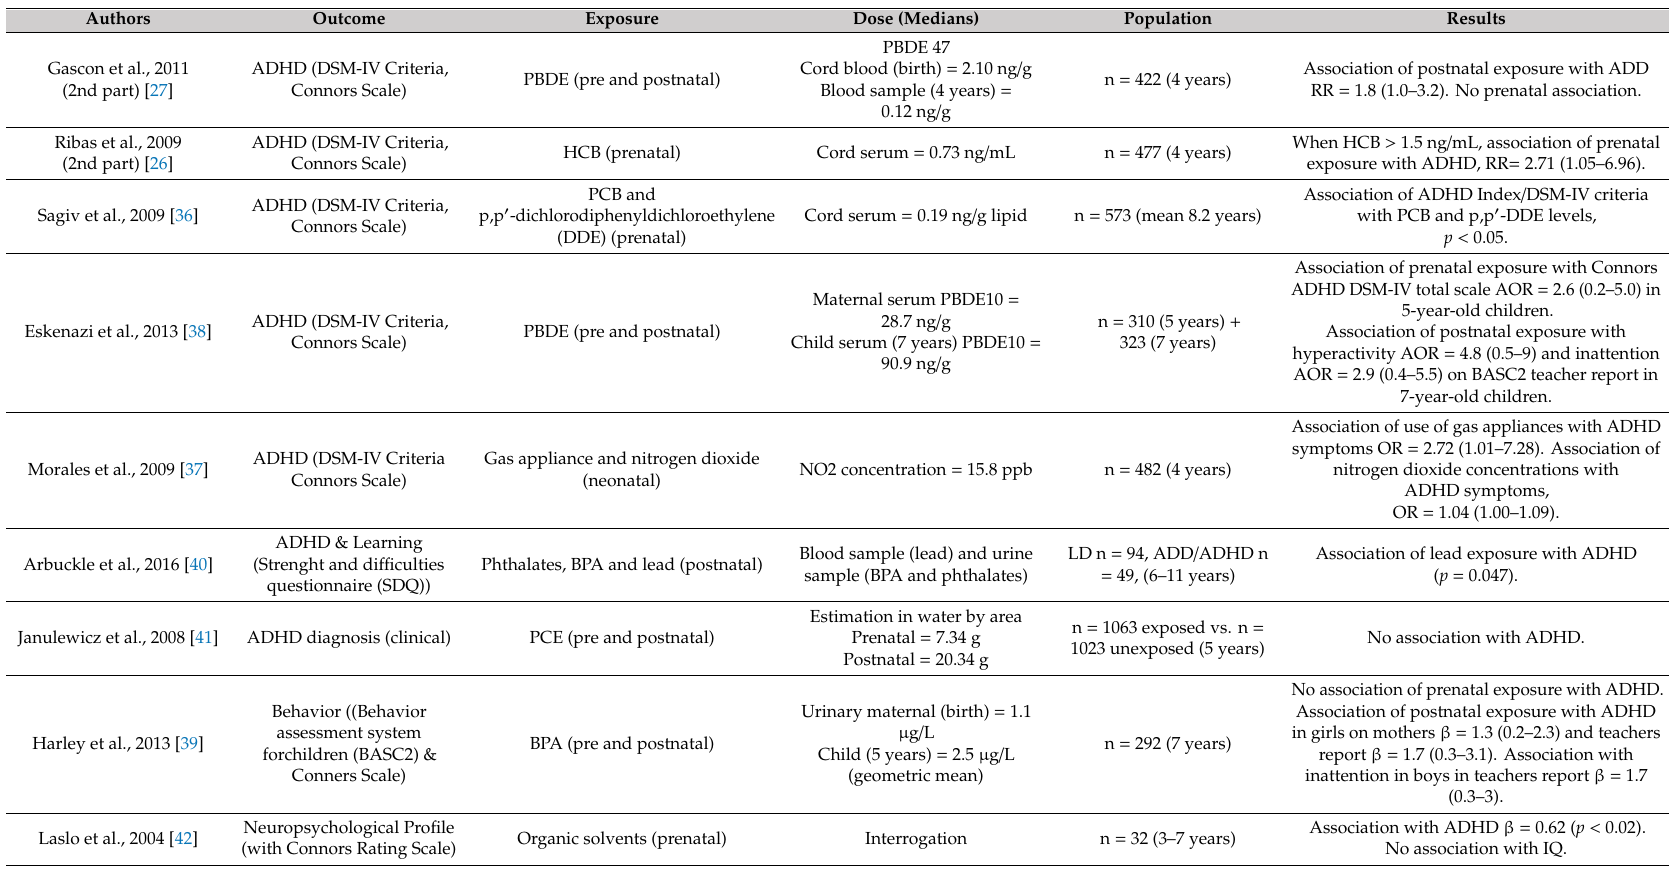
Table 2. Endocrine disruptors and attention-deficit hyperactivity